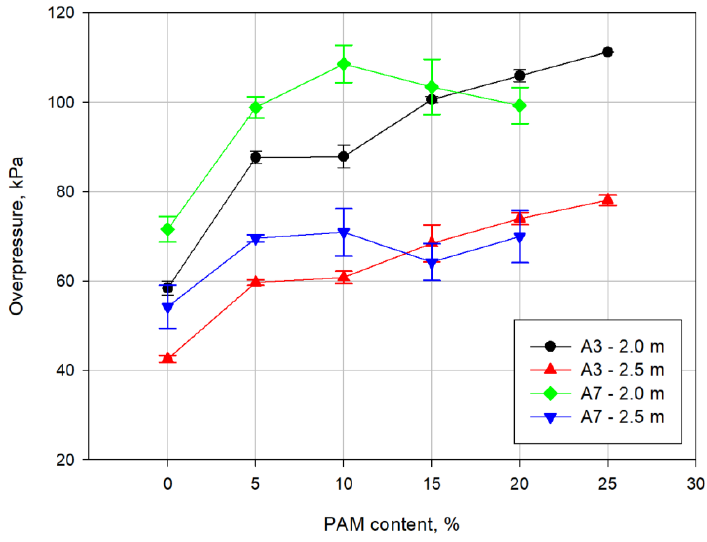
Figure 8. Curves of blast waves overpressure as a function of the PAM powder content.